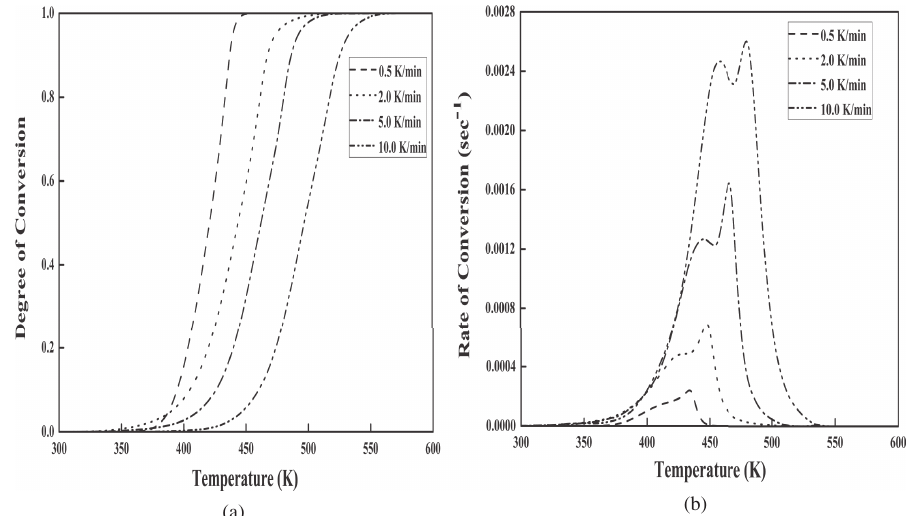
Figure 4: (a) Degree of conver- sion and (b) rate of conversion in dynamic curing process at dif- ferent heating